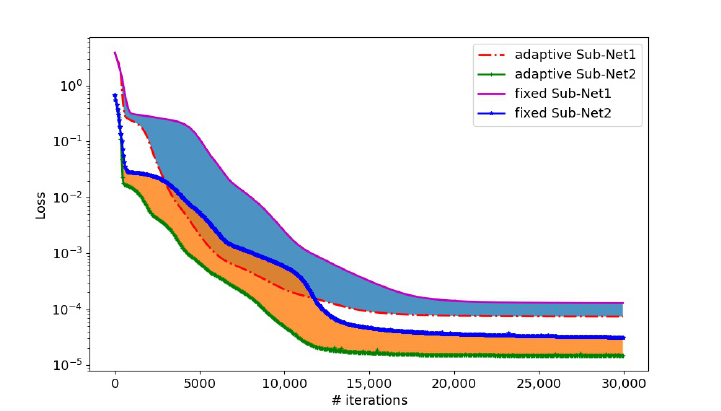
Figure 9. ( a ) The PINN solution and ( b ) the error between PINN and exact solutions for Exampe 3.